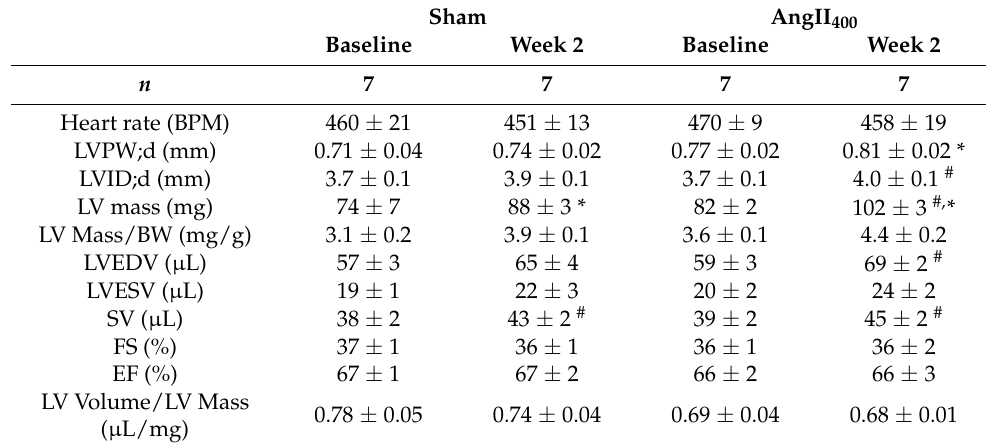
Table 2. In vivo left ventricular function assessed by transthoracic echocardiography in C57BL/6J mice treated with slow pressure dose of angiotensin II (AngII 400 ) or saline (sham) for two weeks. Measurements were obtained and analysed from parasternal short-axis M-mode. Data are presented as mean ±